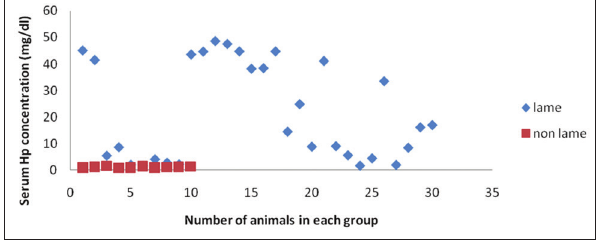
Figure-4: Scatter diagram showing C-reactive protein concentration in lame and non-lame healthy crossbred